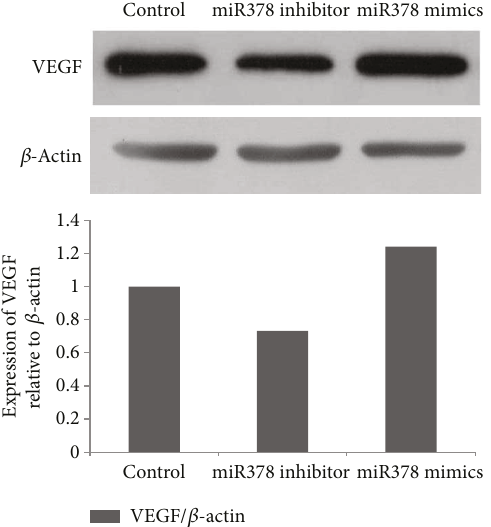
Figure 6: Determination of expression for detection of VEGF by Western blot immunoassay. VEGF was enhanced and reduced by overexpression and inhibition of miR-378 expression,